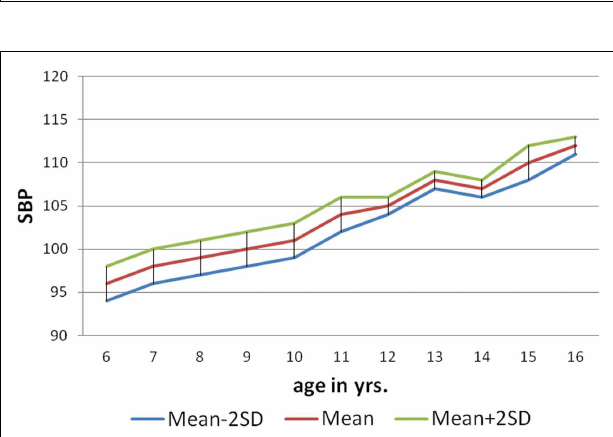
FIGURE 2 | Norms of mean DBP according to age in boys (6–16years) .